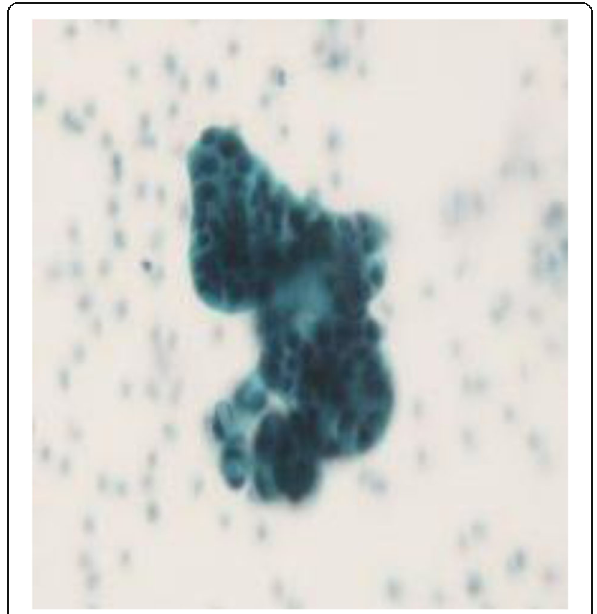
Fig. 3 Abdominal magnetic resonance imaging demonstrating T2 high and a fluid-fluid level